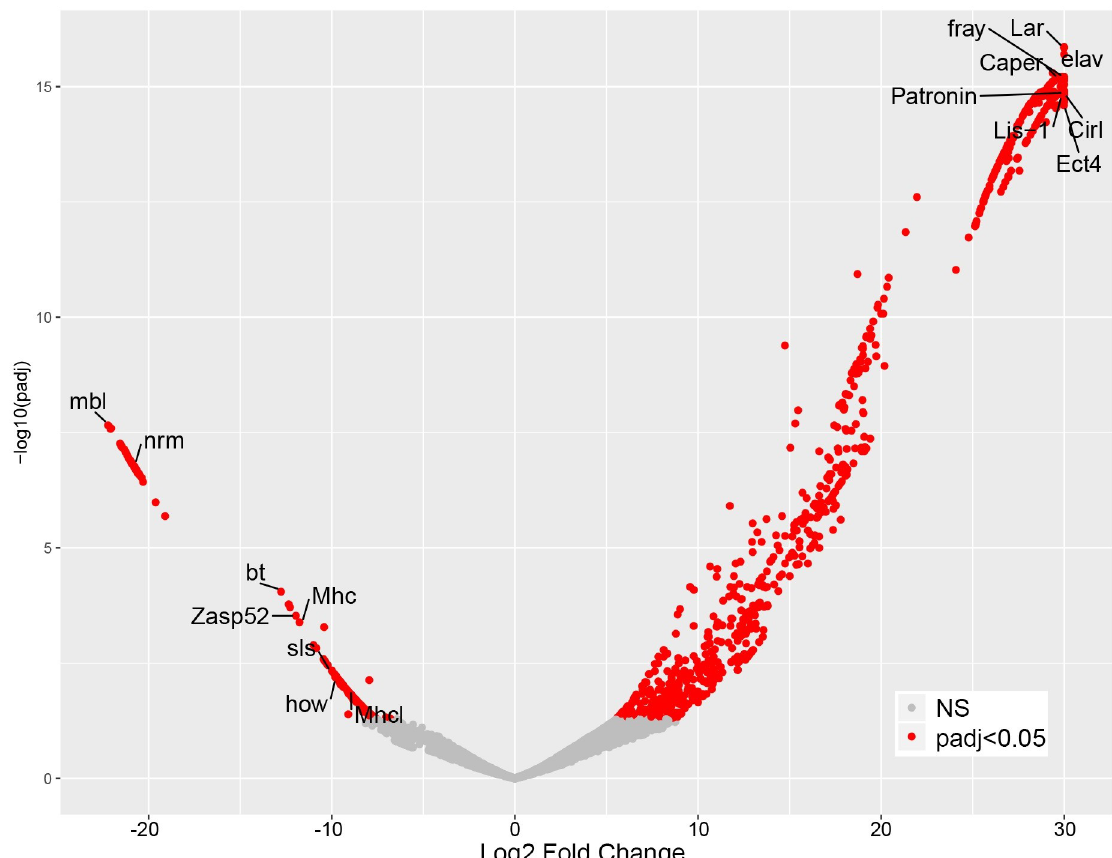
Fig 1. Identification of md neuron enriched and depleted transcripts. Volcano plot of differential expression results showing the log 2 fold change for EC-tagged TPM / EUd-tagged TPM (x-axis) and the adjusted p-value for each transcript (y-axis). NS = not significant. Select genes with known md neuron expression (enriched side of plot) and known muscle expression (depleted side of plot) are labeled.